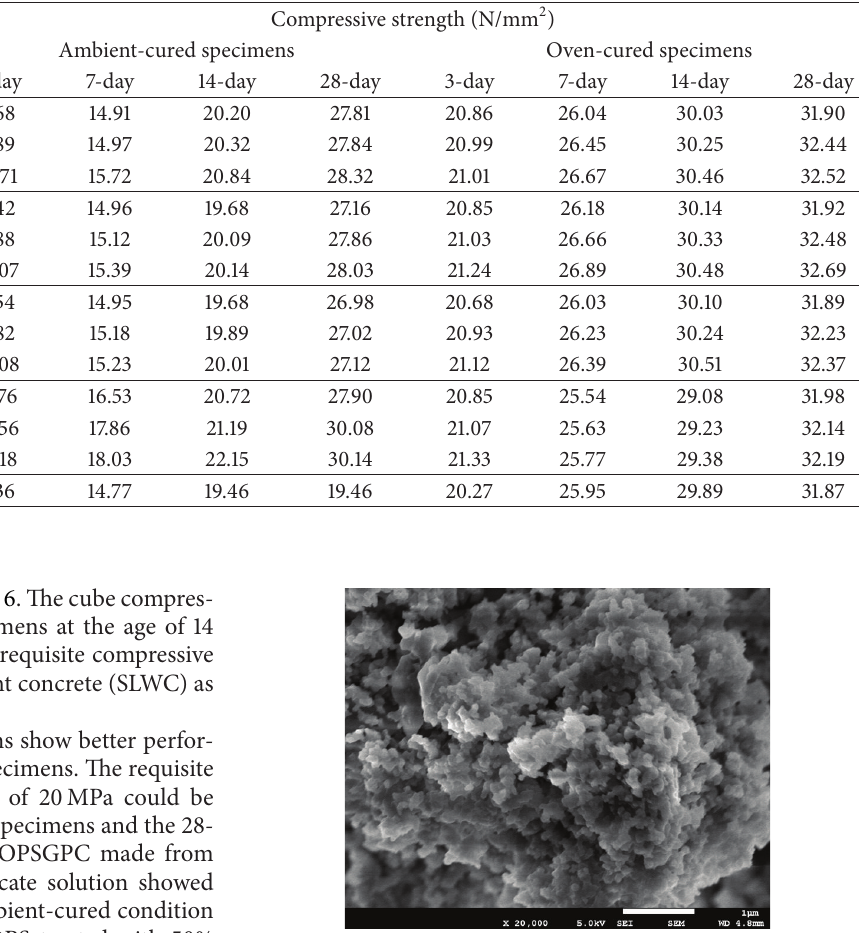
Table 6: Compressive strength of OPSGPC in different ages with different pretreated OPS.